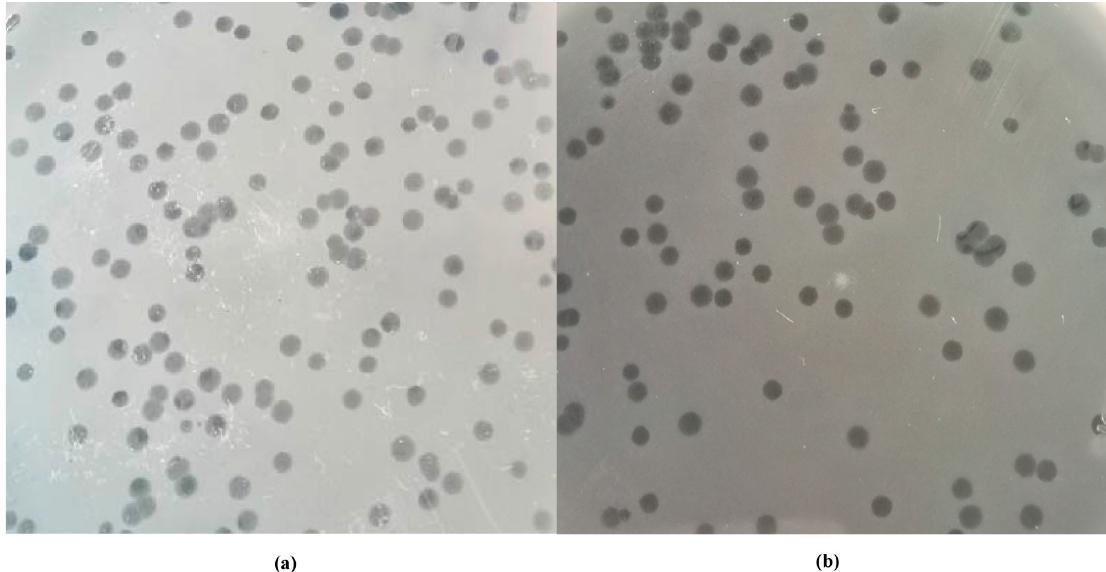
Figure 1. Morphology on double − layer agar plates. ( a ) phage PSE-D1. ( b ) phage PST-H1. Table 1. Host strains information of phage PST-H1 and